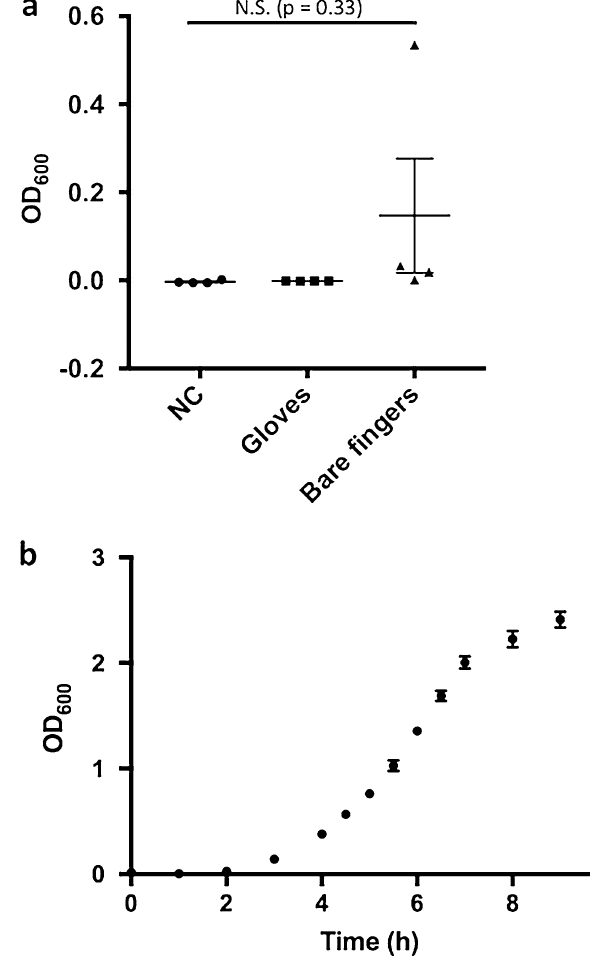
Figure 1. Experimental PIS conditions established. ( a ) NC (negative control) indicates no-treated medium. Values are expressed as mean ± SEM, n = 4; One-way ANOVA. ( b ) Growth curve of DH-5 alpha. At time 0, 10,000 cells/mL (2 mL) of DH-5 alpha were inoculated in LB medium and cultured in constant shaking conditions at 37 °C. Each indicator is shown as mean ± SEM, n =